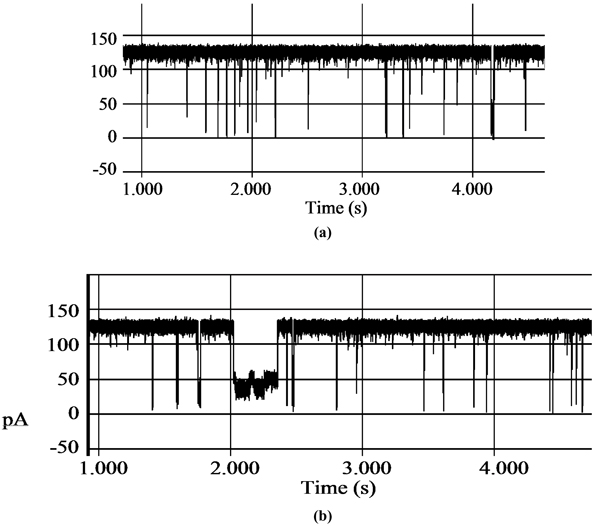
The preliminary aptamer experiments are based on the DNA molecule obtained from annealing ssDNA1: 5'-CAAGCTTGGTTTCGATAGGTA-3' with ssDNA2: 5'-ATCGTTTCCAAGCTTG-3'. For the pseudo-aptamer binding experiment a solution of annealed ssDNA1 and SSDNA2 molecules was exposed to ssDNA3: 5'-TACCT-3' (which anneals to the remaining AGGTA complement on ssDNA1). The target 5-base ssDNA is introduced subsequent to obtaining a toggler-type capture of the aptamer molecule (properly annealed). The aptamer experiment is referred to above as a pseudo-aptamer experiment due to its simplification to a DNA annealing detection. The short blockades in (a) result from ssDNA translocation by the un-annealed or partially annealed (mismatched) ssDNA components. The brief blockade in (b) is hypothesized to be due to capture with the overhang end entering first (and subsequent rapid melting of the annealed molecule – akin to that seem in the DNA hairpin experiments [12]).